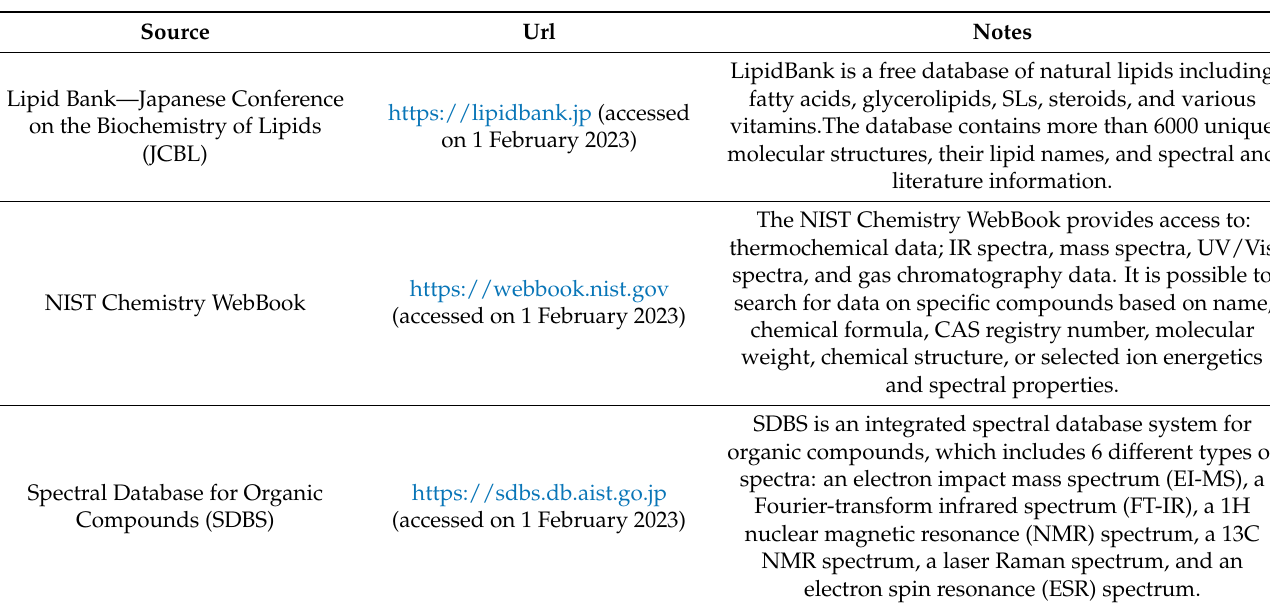
Table 1. Online databases with information on lipids and